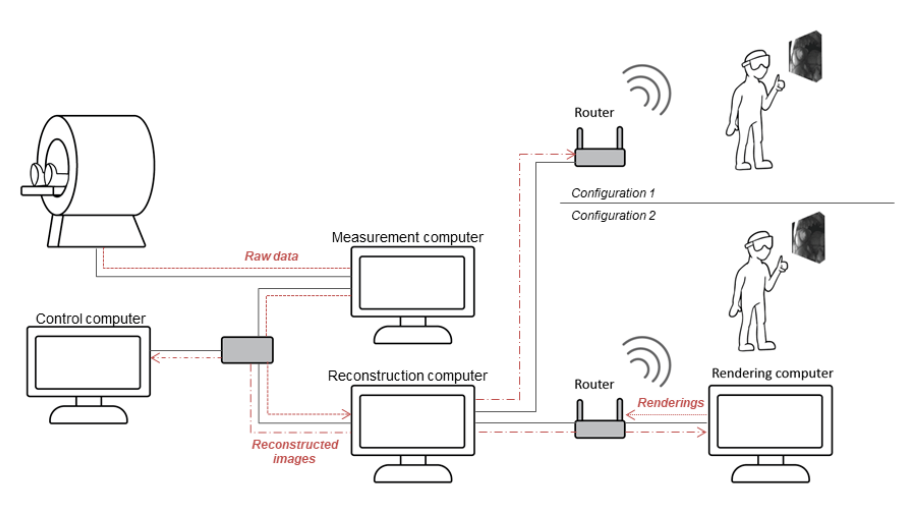
Figure 2. Schematic of data flow within the online acquisition, reconstruction, and mixed-reality rendering system. A dedicated image reconstruction computer was introduced into the network containing the scanner, the scanner control computer, and the scanner measurement computer via a switch and an Ethernet cable. A second network was set up using a router to contain the reconstruction computer and the mixed-reality headset. Two configurations were possible. In the first, reconstructed data are sent directly to a self-contained HMD capable of handling the entire rendering pipeline. In the second, a dedicated rendering workstation is used. The reconstruction and rendering computers are connected via Ethernet cables, and rendered frame data are transferred wirelessly to the headset. Solid gray lines show component connections, and dashed red lines depict data